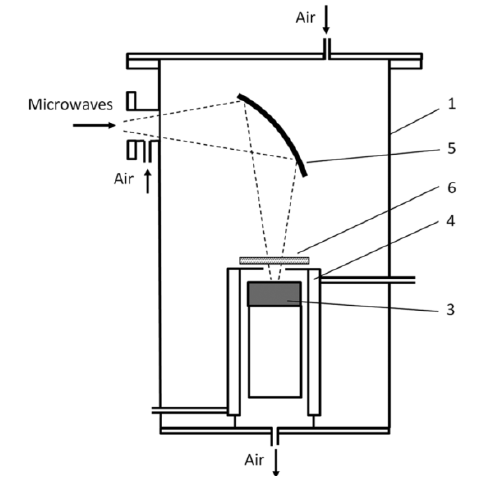
Fig. 1. Schematic view of the evaporation – condensation sec-